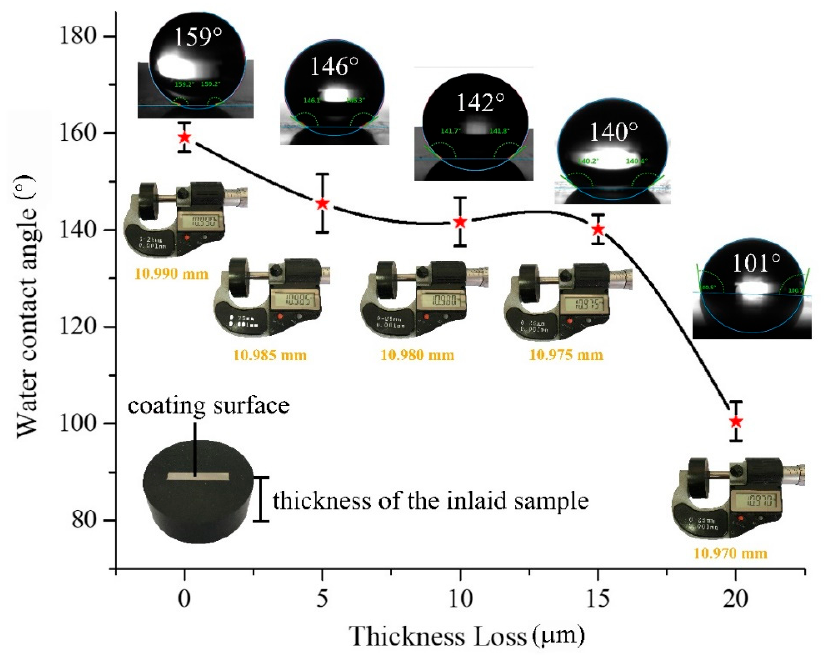
Figure 8. Water repellent performance and anti-adhesion behavior of the unmodified aluminum oxide film and the superhydrophobic PFDS / TiO 2 @AAO. ( a ) Water repellent performance of the unmodified aluminum oxide film. ( b ) Schematic illustration of the bacterial adhesion on the unmodified aluminum oxide film. ( c , d ) Bacterial adhesion testing of the unmodified aluminum oxide film against the bacteria of E. coli and S. aureus . ( e ) Water repellent performance of the surface with the superhydrophobic PFDS / TiO 2 @AAO. ( f ) Schematic illustration of the bacterial adhesion on the surface with the superhydrophobic PFDS / TiO 2 @AAO. ( g , h ) Bacterial adhesion testing of the superhydrophobic PFDS / TiO 2 @AAO against the bacteria of E. coli and S. aureus .